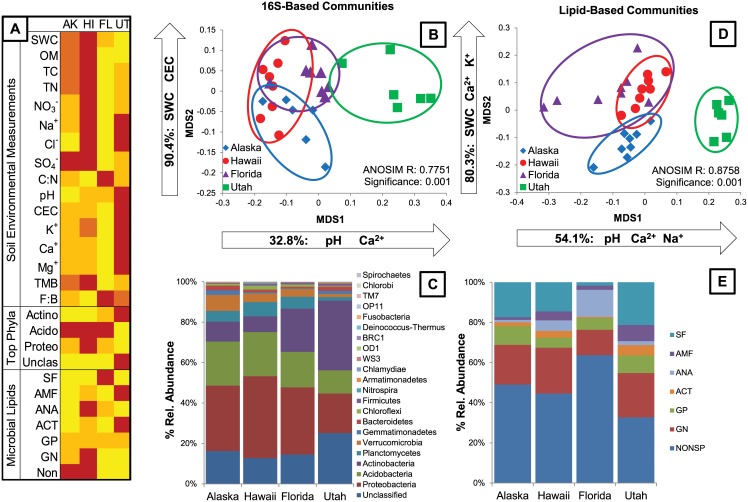
Microbial community variation across sites at the time point closest to peak greenness for the site.(A) Heatmap representing significant differences (α = 0.05) between soil environmental variables, the most abundant 16S-based phyla and grouped lipids. Changes in color represent a significant difference, where red is the highest average value and yellow is the average value. (B) NMDS ordination of 16S rRNA-based communities at the phylum level indicates significant differences in community composition by site (ANOSIM R = 0.7751, significance = 0.001). pH and Ca2+ explaining 32.8% of the variation in MDS1; SWC and CEC explain 90.4% of the variation in MDS2. (C) Percent relative abundance of all unclassified taxa and identified phyla using 16S rRNA data. (D) NMDS ordination of lipid-based communities indicates significant differences in community composition by site (ANOSIM R = 0.8758, significance = 0.001). pH, Ca2+ and Na+ explain 54.1% of the variation in MDS1; SWC, Ca2+ and K+ explain 80.3% of the variation in MDS2. (E) Relative abundance of nonspecific and diagnostic lipids for Gram Negative Bacteria (GN), Gram Positive Bacteria (GP), Actinobacteria (ACT), Anaerobic Bacteria (ANA), Arbuscular Mycorrhizal Fungi (AMF) and Saprophytic Fungi (SF).